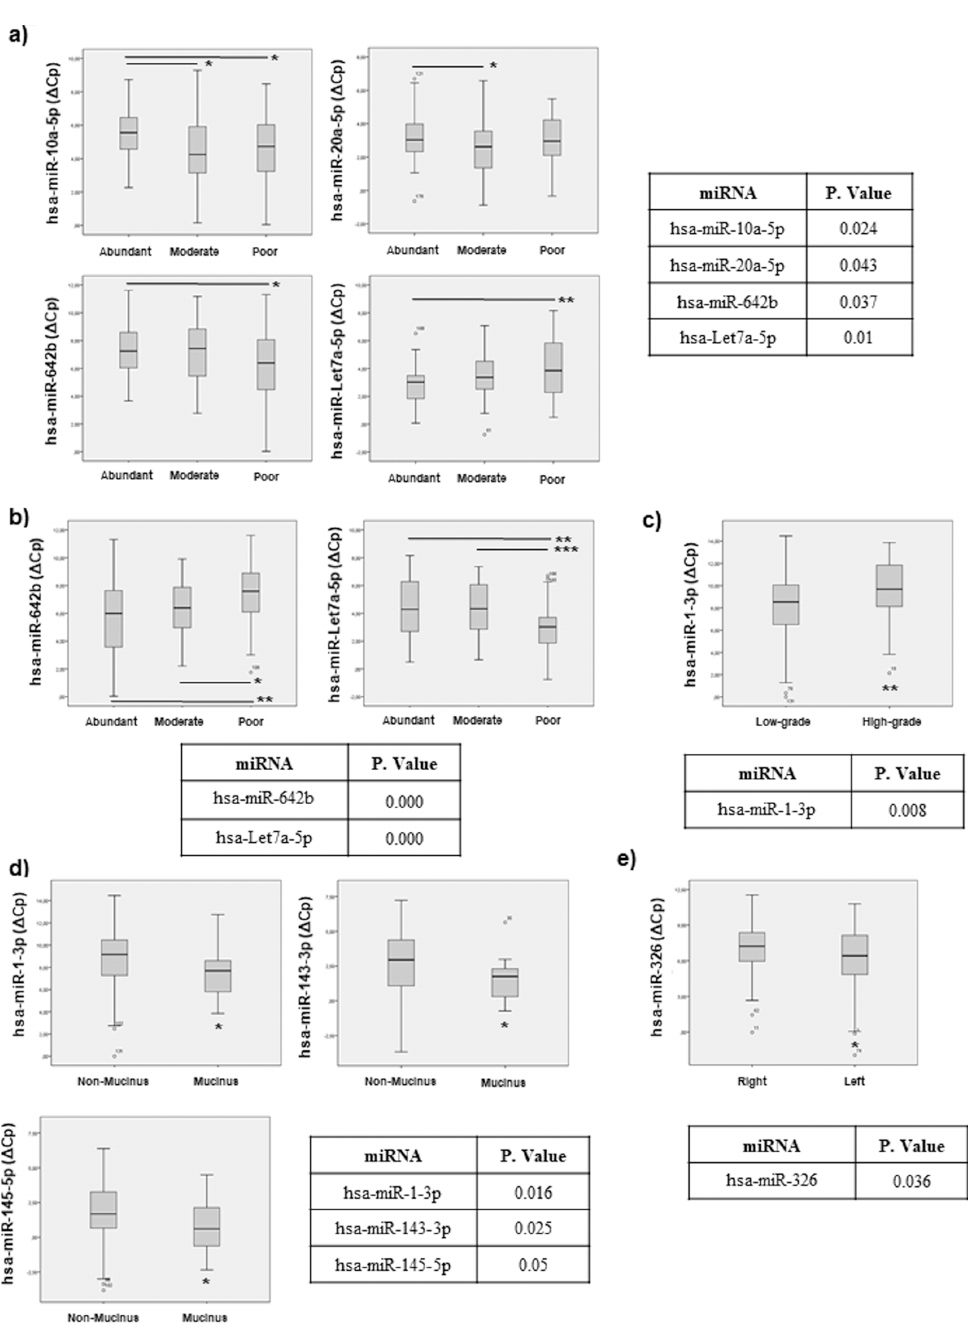
Figure 3. Statistical correlation of the selected miRNAs and biopsy histopathological features. Statistical analysis using SPSS 19.0 between miRNAs levels expressed as DCT was performed and data regarding correlation with: ( a ) stromal component, ( b ) peritumoral inflammatory infiltrate, ( c ) tumour grade, ( d ) mucinous component and ( e ) tumour location, are presented. Only miRNAs exhibiting statistically significant correlations are shown. Data are presented as median and interquartile range with: * p < 0.05, ** p < 0.01, *** p < 0.001. We have also studied the association between miRNAs and tumour grade, finding that miR ‐ 1 ‐ 3p was differentially expressed between low and high ‐ grade tumours (Figure 3c). Furthermore, we